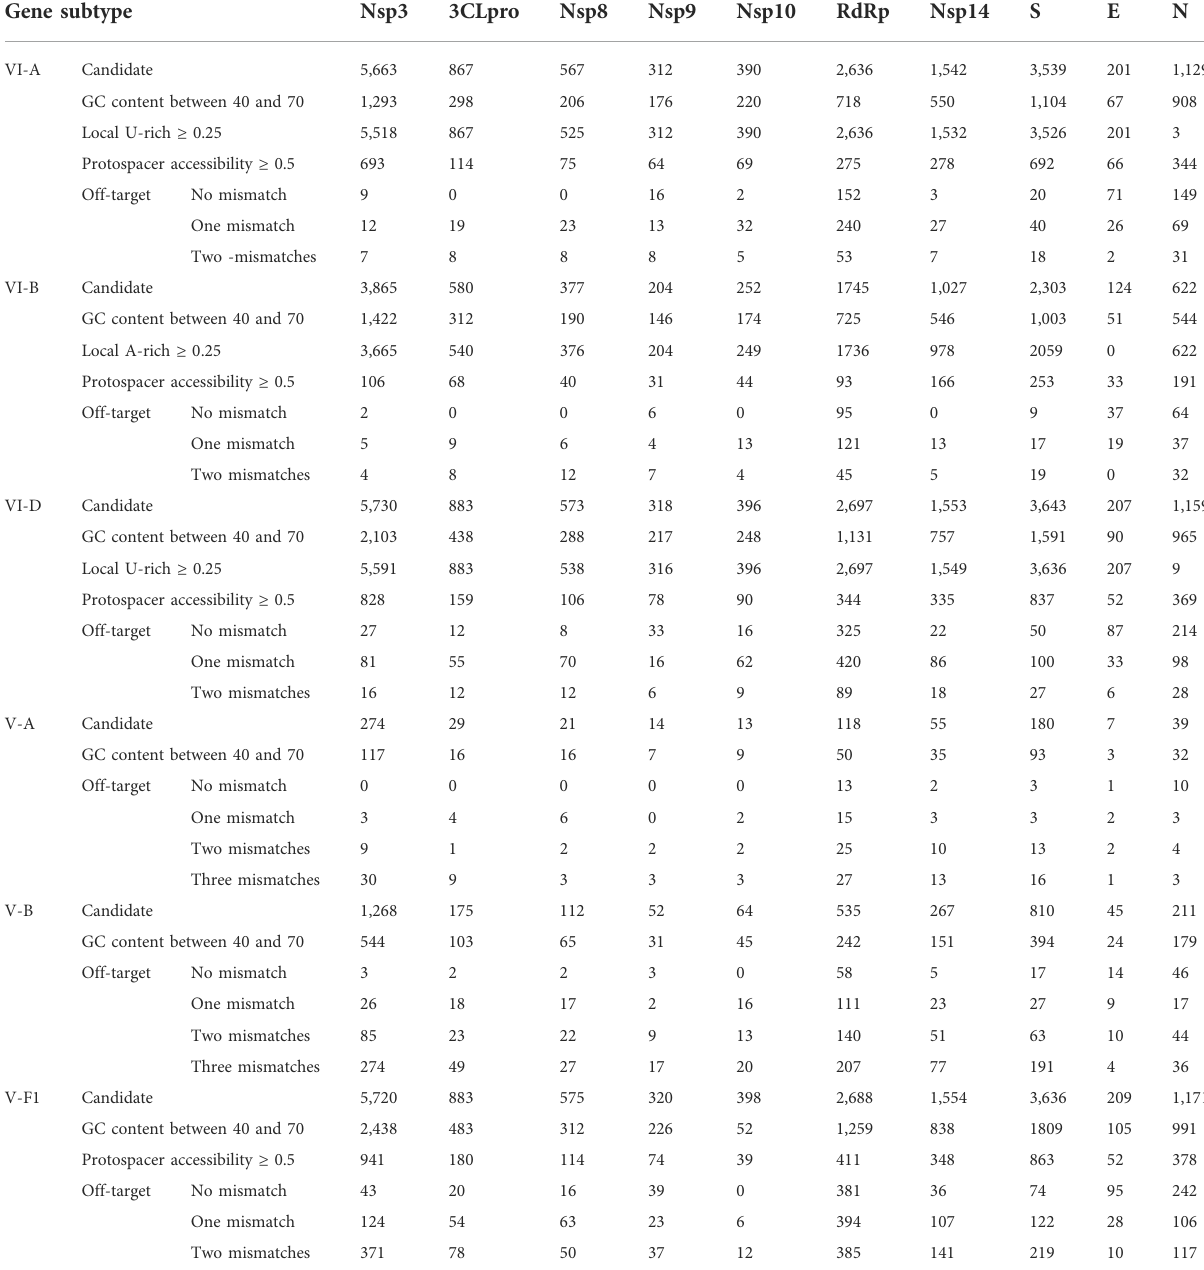
TABLE 5 Result of crRNA designing for ten genes of SARS-CoV-2 by